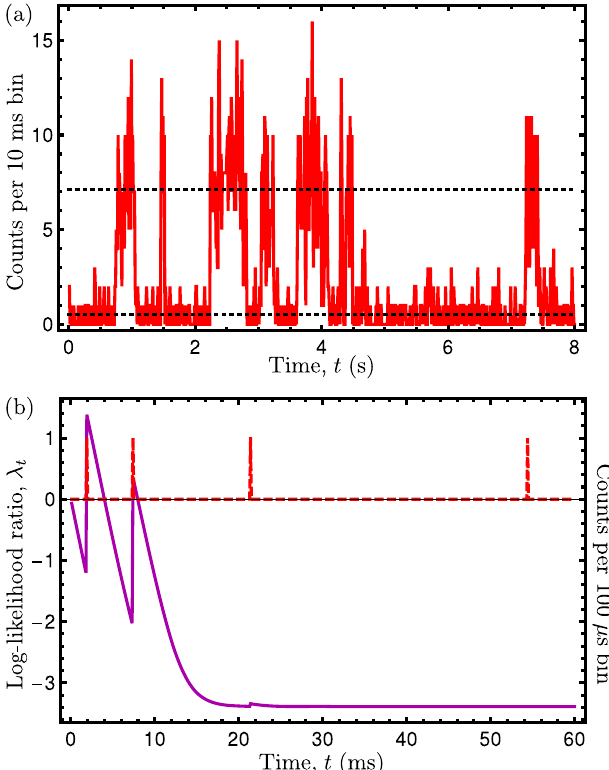
FIG. 4. (a) Experimental photon-count trajectory illustrating the state-dependent fluorescence rate and two-level switching of the NV-center charge state for an illumination power of 0 . 55 μ W. ≈ 720 Hz Here, the photon detection rate fluctuates between γ þ for NV − and γ − ≈ 50 Hz for NV 0 , as discussed in Sec. IV B. The corresponding average counts per 10-ms bin are indicated by the horizontal dotted black lines. The NV-center ionization and ≈ 3 . 6 Hz and recombination rates are found to be Γ þ Γ ≈ 0 . 98 Hz, respectively. (b) Log-likelihood ratio λ (solid − t magenta) and counts per 100- μ s bin (dashed red) for the first 60 ms of the data shown in (a). The log-likelihood ratio was calculated using Eq. (8) and the experimental parameters given in Sec. IV B. The discontinuities in λ indicate the detection of a t